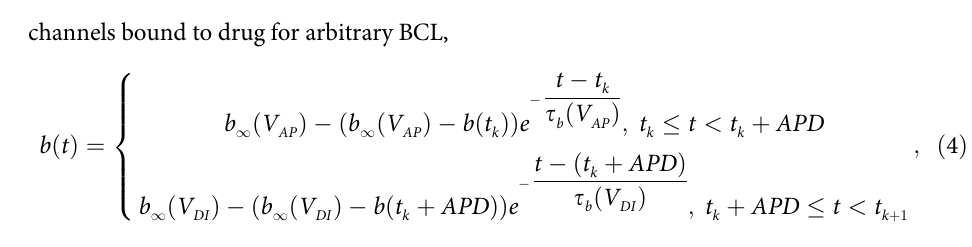
Fig 5. Mechanism of lidocaine rate-dependent effects. (A) Simulated action potentials of our modified ten Tusscher et al. model paced at a BCL of 750 ms with 20 μM lidocaine (blue) and a square wave approximation of the action potential (orange) that alternates between -85 mV and 20 mV . (B) Dynamics of the fraction of channels bound to drug, b , with 20 μM lidocaine present in our modified ten Tusscher et al. model (blue) and low-dimensional Na + conductance model stimulated by the square wave approximation (orange). (C) Voltage dependence of 1 − h 1 (dashed green) and b 1 for 20 μM (yellow) and 5 μM (purple) lidocaine. (D) Voltage dependence of τ b for 20 μM (yellow) and 5 μM (purple) lidocaine.